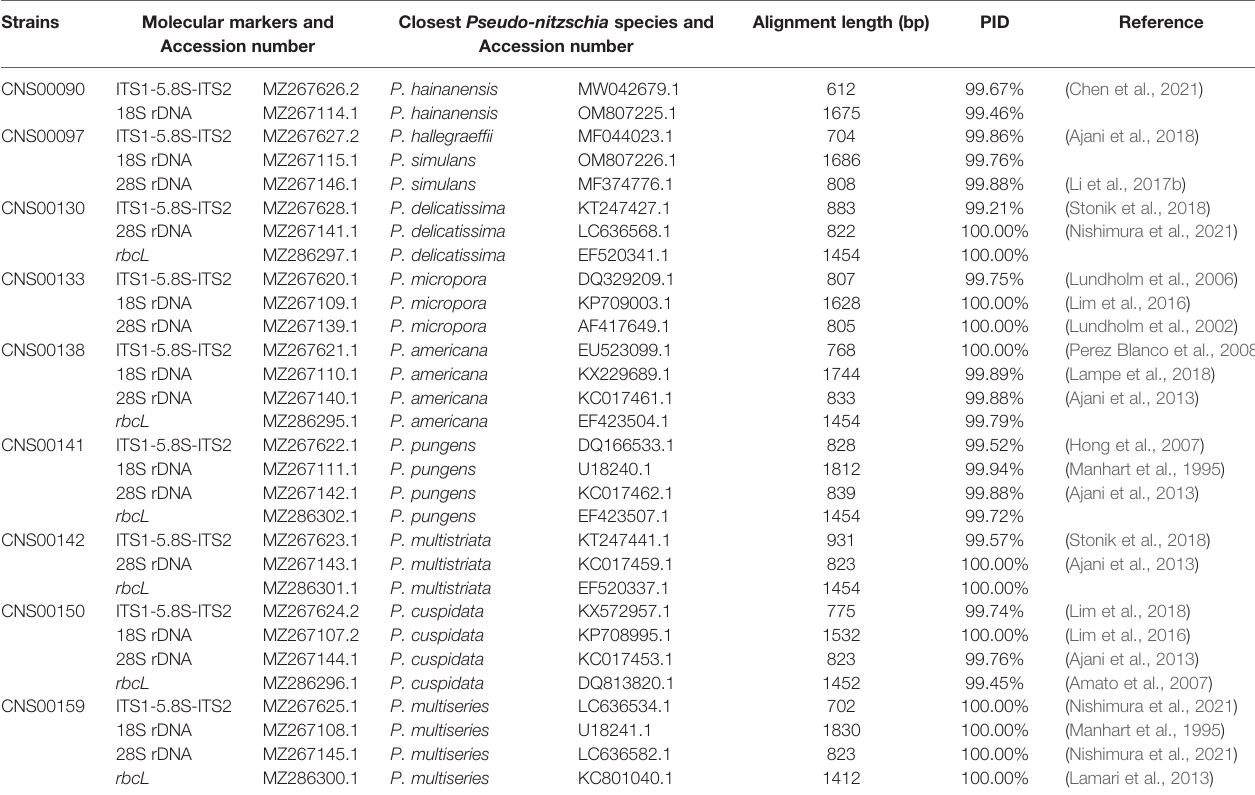
TABLE 2 | Species identi fi cation of nine strains based on multiple molecular markers. Strains Molecular markers and Accession